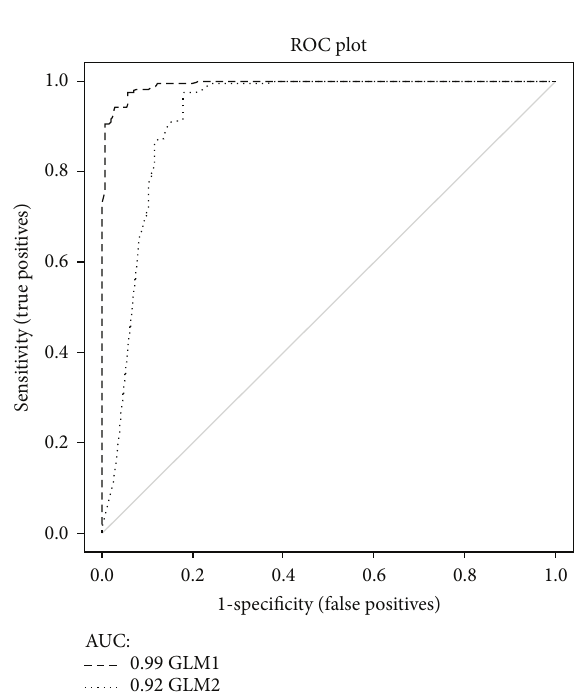
Figure 1: ROC curves and the corresponding AUC values for the two binary GLMs included in the study.